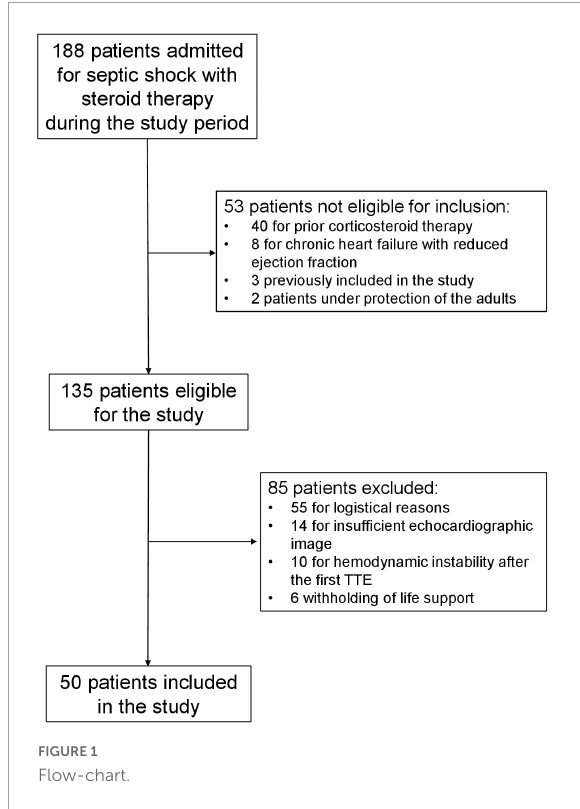
FIGURE1 Flow-chart.